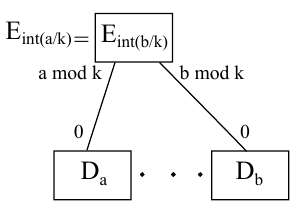
Figure 9. Schematic diagram for intraedge